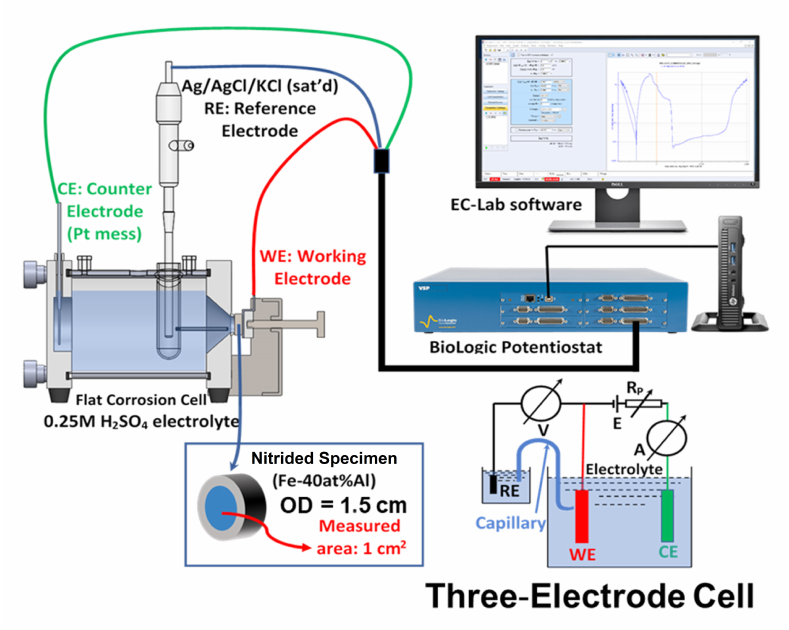
Figure 1. Schematic overview of the electrochemical experiments conducted with a corrosion